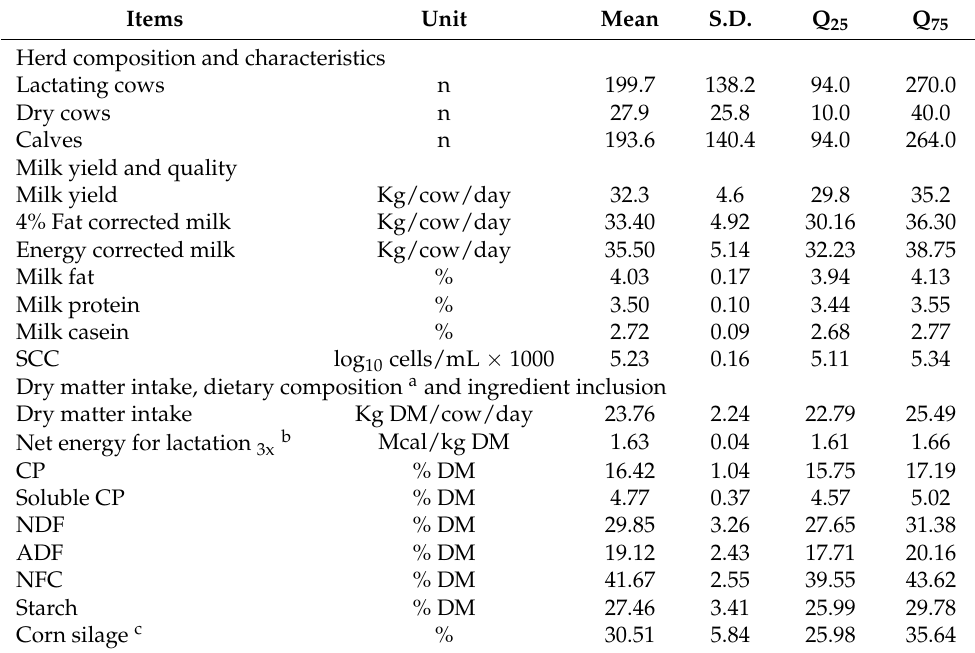
Table 1. Descriptive statistics of herd composition and characteristics, together with parameters related to milk yield and quality, dry matter intake, dietary composition, and ingredient inclusion.